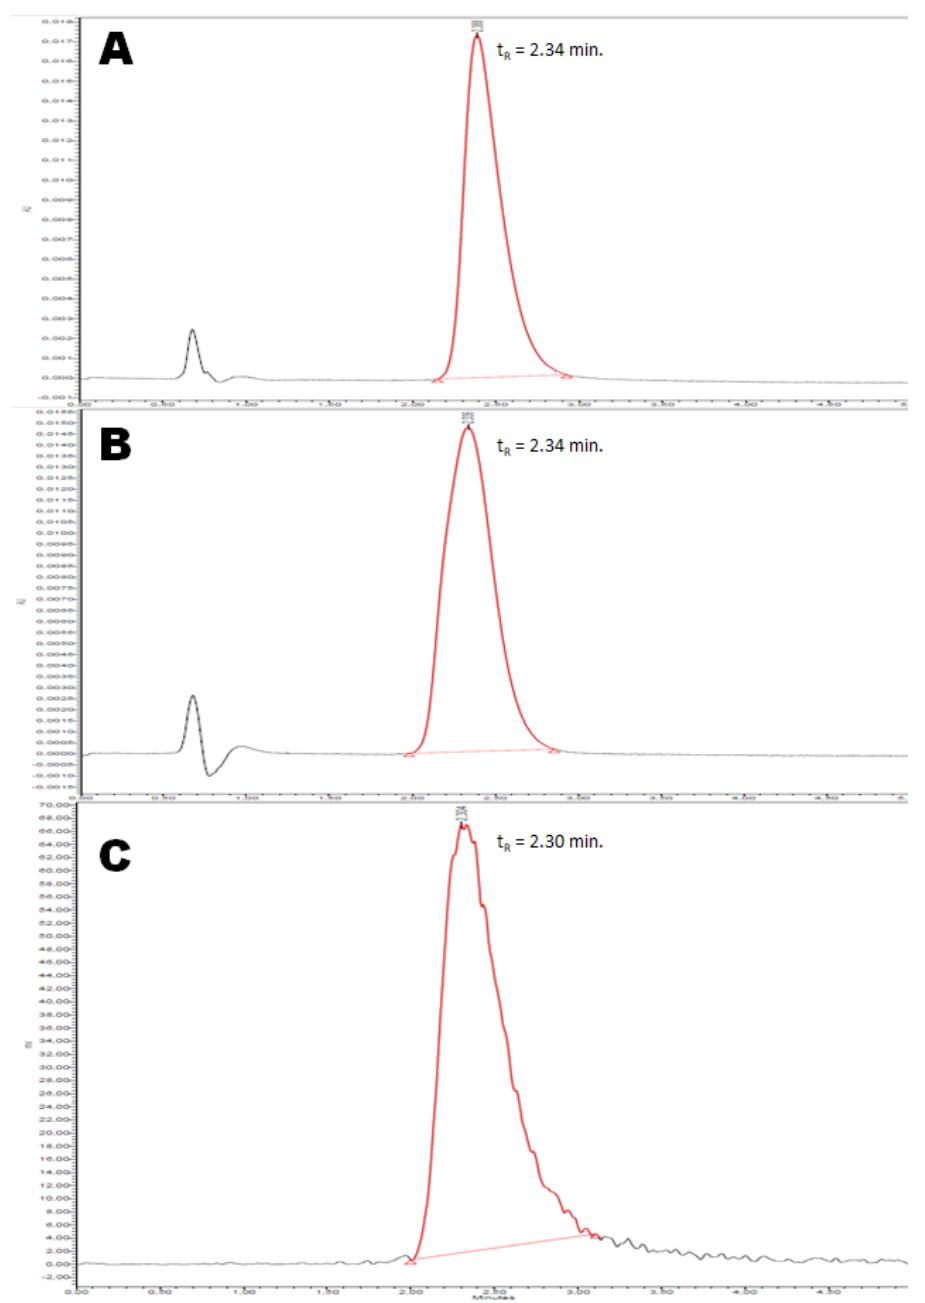
Figure 3. Quality control of [ 18 F] (R,S) -crizotinib by analytical HPLC realized on a reverse-phase analytical Symmetry ® C18 150 × 3.9 mm, 5 µm (Waters, Milford, MA, USA) column using a mixture of H 2 O/MeOH/THF/TFA (70/20/10/0.1 v/v/v/v , 2 mL/min) as eluent. UV detection was performed at 333 nm. ( A ) UV chromatogram of the reference compound crizotinib; ( B ) UV chromatogram of the radiotracer [ 18 F] (R,S) -crizotinib; ( C ) Gamma chromatogram of the radiotracer [ 18 F] (R,S) -crizotinib.